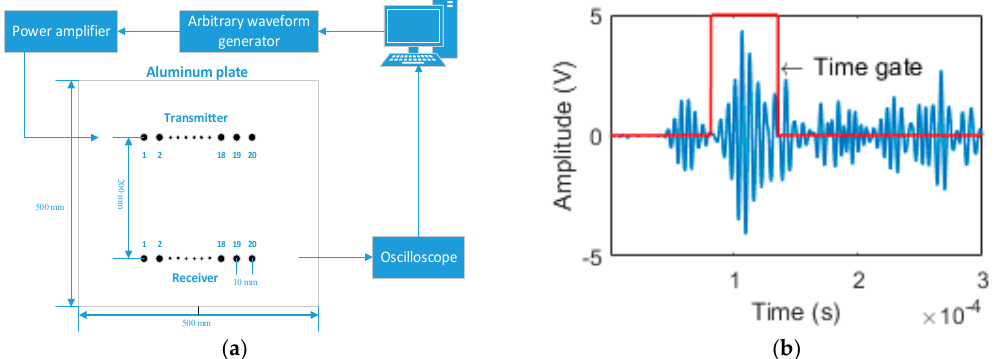
Figure 4. ( a ) Structure health monitoring (SHM) system diagram. ( b ) Typical time trace from the experiment with chosen time